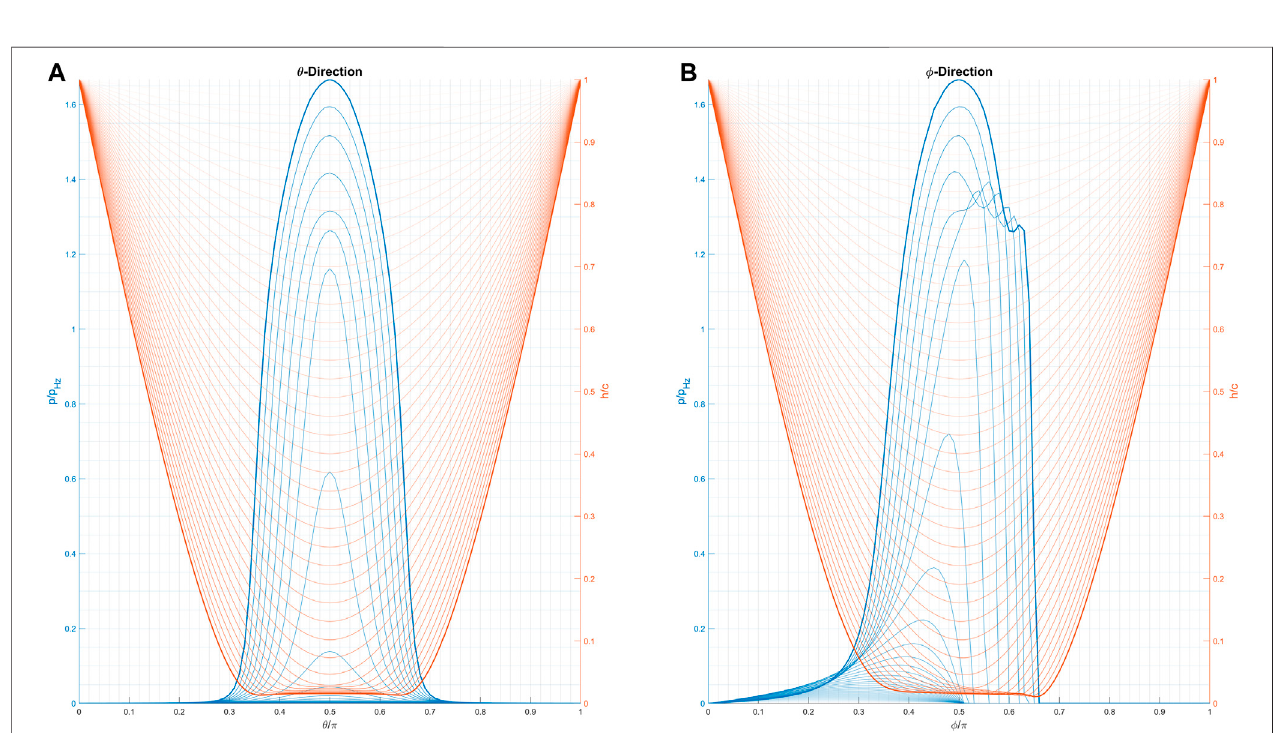
FIGURE 7 | Lubricant pressure and surface separation pro fi les evolution along θ (A) and φ (B) .